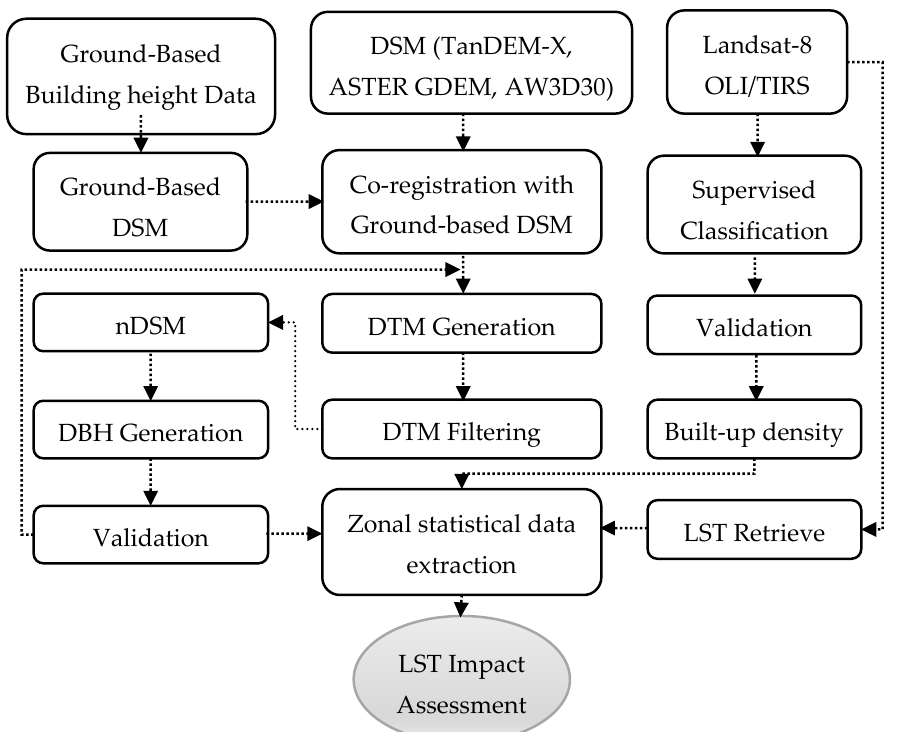
Figure 4. Outline of the methodology adopted.